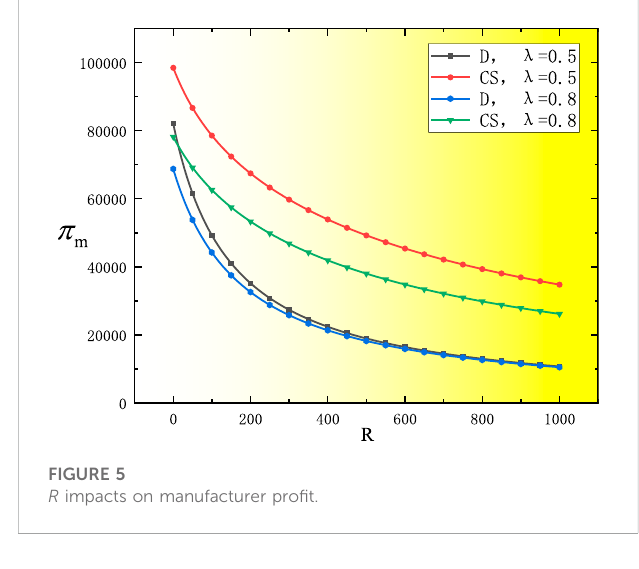
FIGURE 5 R impacts on manufacturer pro fi t.